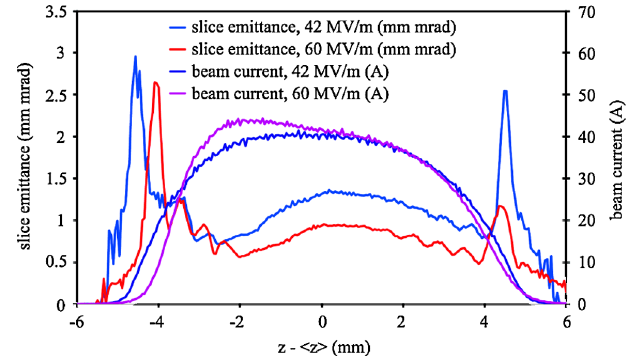
FIG. 33. (Color) Simulated bunch current profiles and slice emittance 4.3 m downstream of the cathode for the optimized cases 42 and 60 MV = m peak field at the